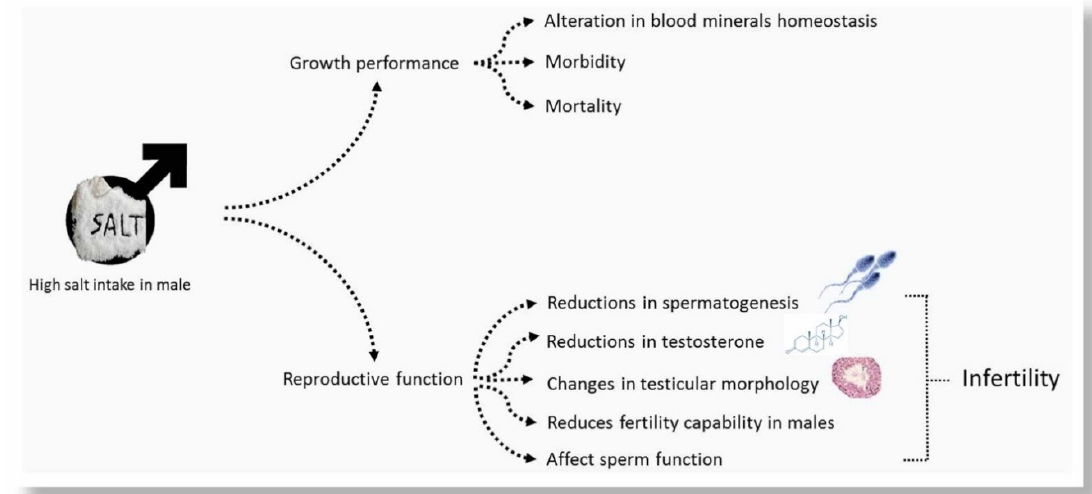
Figure 1. The adverse effect of high salt diet on male animals.